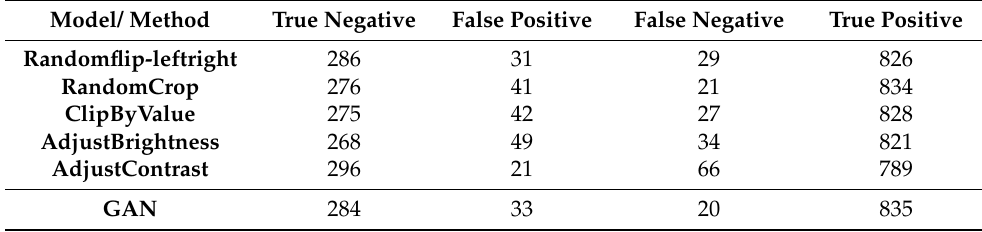
Table 2. Confusion